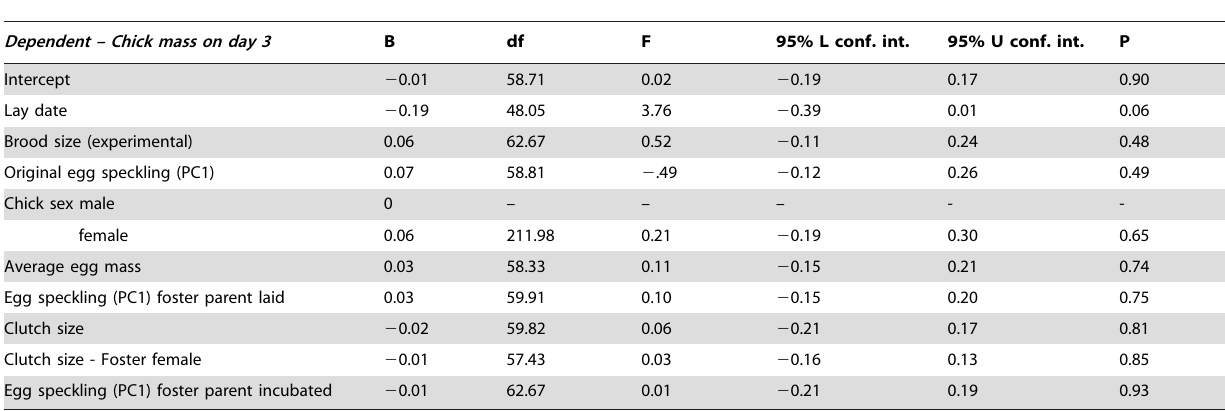
Table 2. DAY 3. Linear Mixed-effects Model showing no effect of egg speckling on chick mass on day 3.